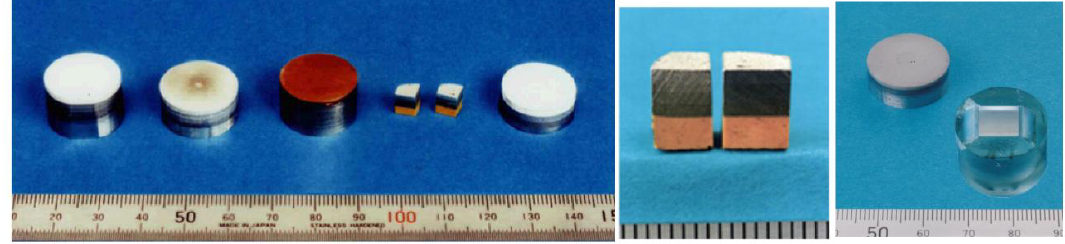
Figure 31. Typical examples of bulk FGMs.